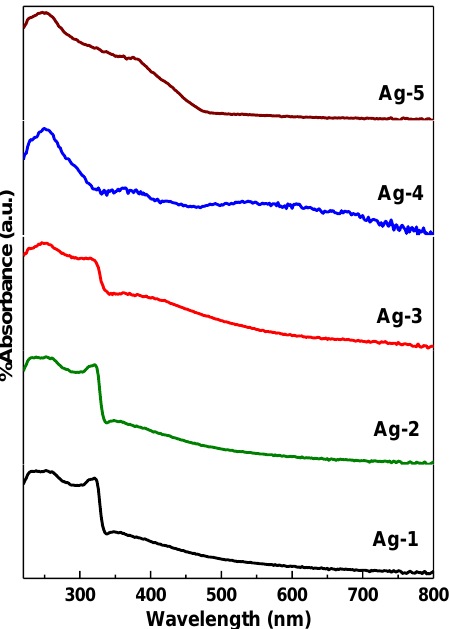
Figure 4. DR UV-vis spectra of synthesized Ag-containing nanomaterials .